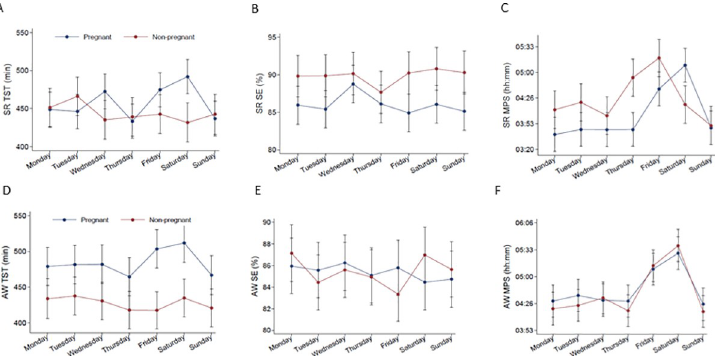
Fig 2. Daily sleep, in pregnant and non-pregnant women. Estimated by linear mixed effects models including group- by-weekday interaction. The p value for time-by-group interaction was (A) p < .001 for Self-reported (SR) total sleep time (TST), (B) p = .192 for Self-reported sleep efficiency (SE), (C) p < .001 for Self-reported midpoint of sleep (MPS) was, (D) p = .183 derived from actigraphy (AW) for total sleep time (TST), (E) p = .027 derived from actigraphy for sleep efficiency (SE), (F) p = .408 derived from actigraphy for midpoint of sleep.